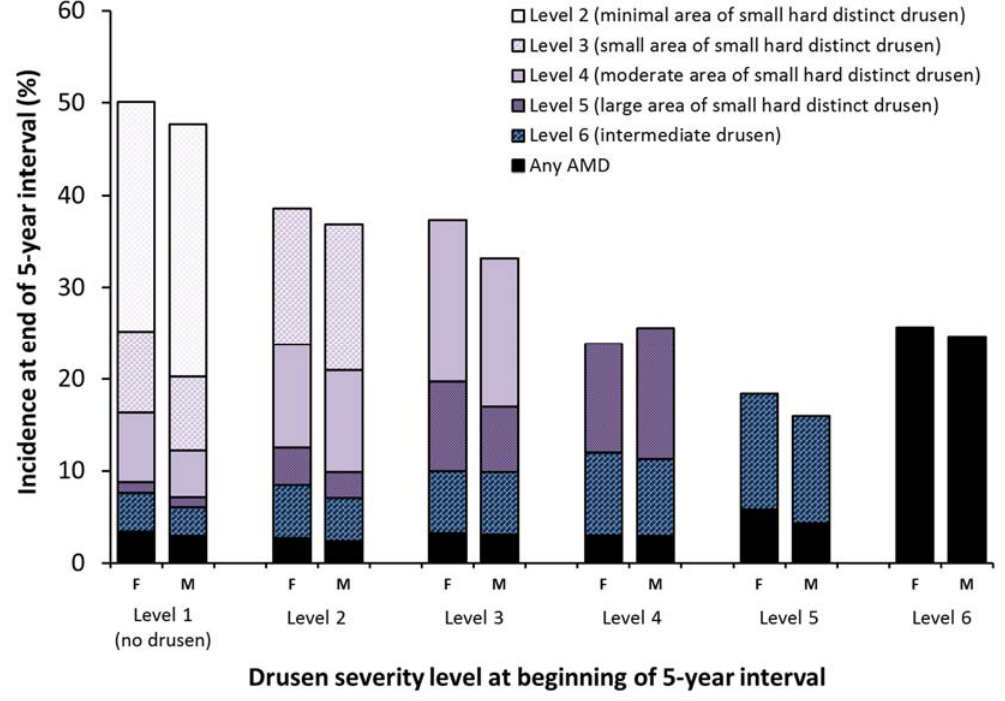
Figure 3. Five-year incidence of increasing area of small hard drusen, intermediate drusen, and any AMD by sex and severity level at the beginning of the interval. F = female; M = male.